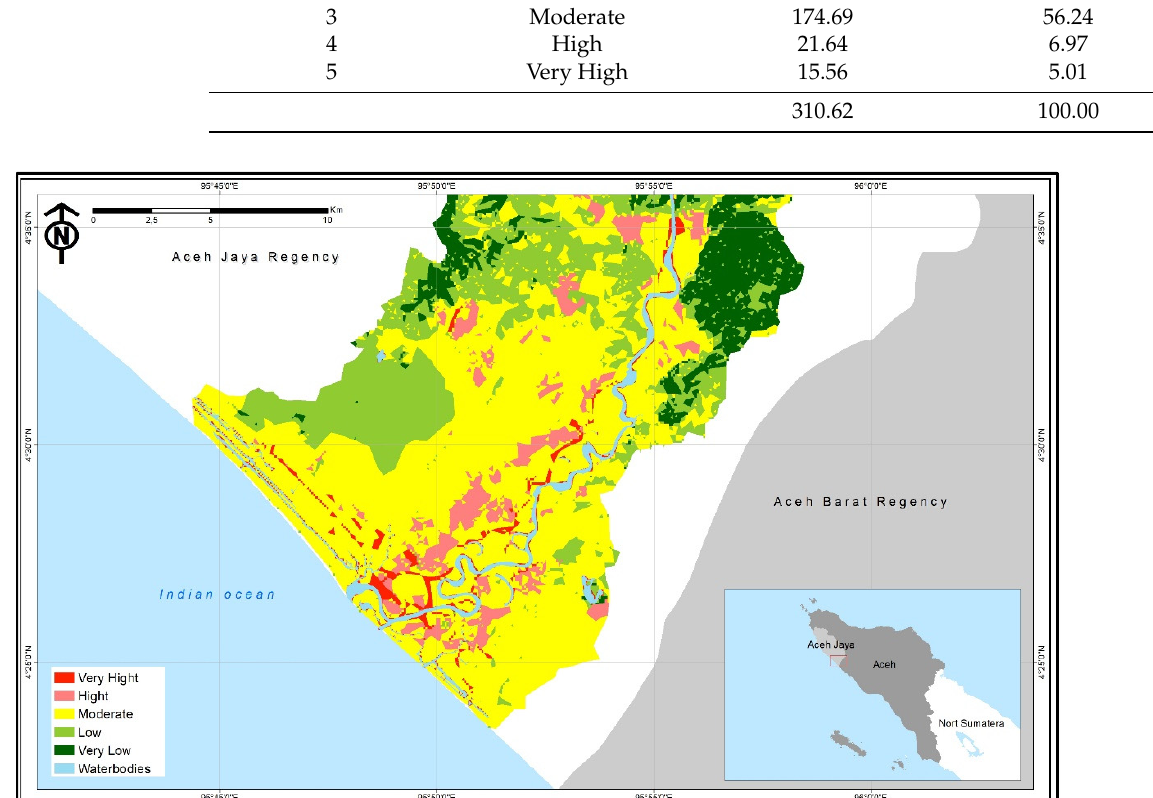
Figure 9. Overlaid flood risk map results from the overall